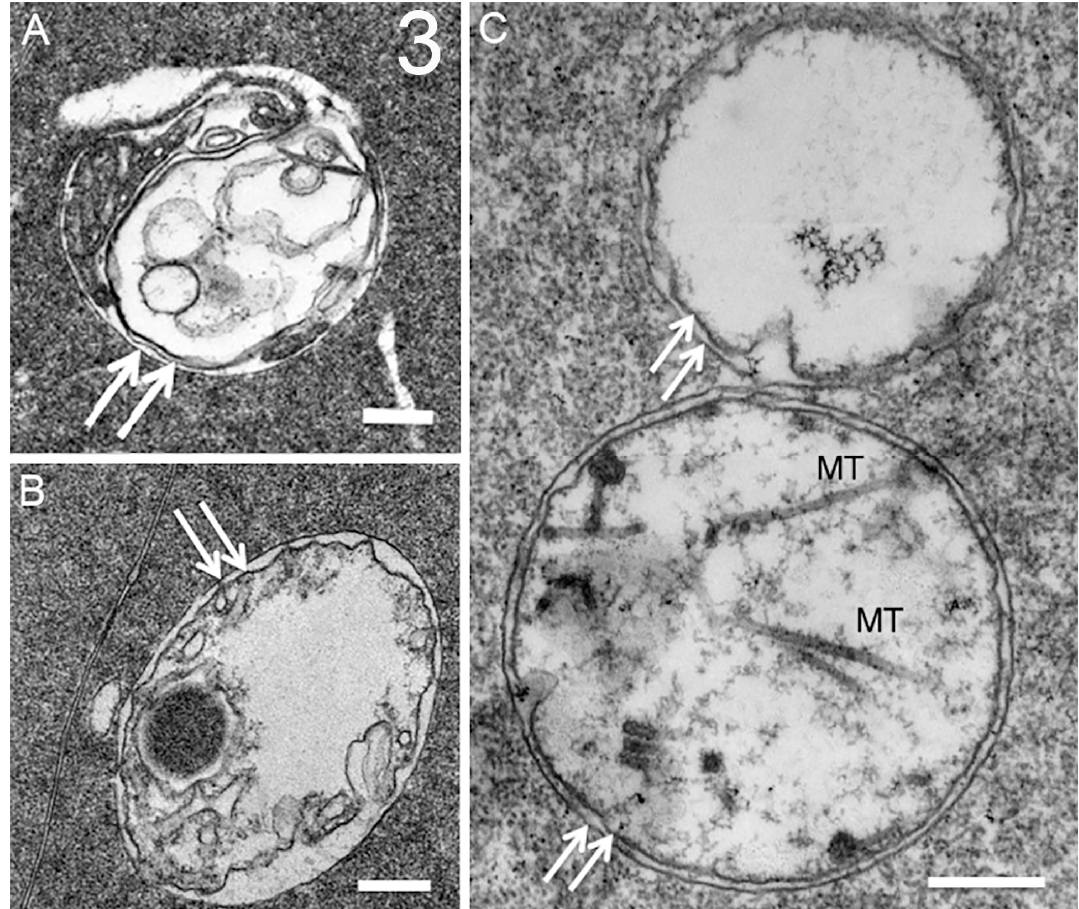
Figure 3. Similar double-membrane autophagosomes are found in lens fiber cells from a variety of diverse species. ( A ) Heterogeneous contents include an elongated structure (upper left), which has internal membranes that are probably partially degraded mitochondrial cristae. Adult human donor lens. ( B ) Heterogeneous contents include a dark, circular, and uniformly stained object that is similar to the core of MLBs (multilamellar bodies). Chick embryo D15 lens. ( C ) Lower double-membrane vesicle displays several structures that are most likely microtubule segments (MT, linear 25 nm diameter tubules), which could only occur within an autophagic vesicle. Adult rabbit lens. Scale bars are 250 nm. Double-membrane cover is indicated by arrows in all four examples.